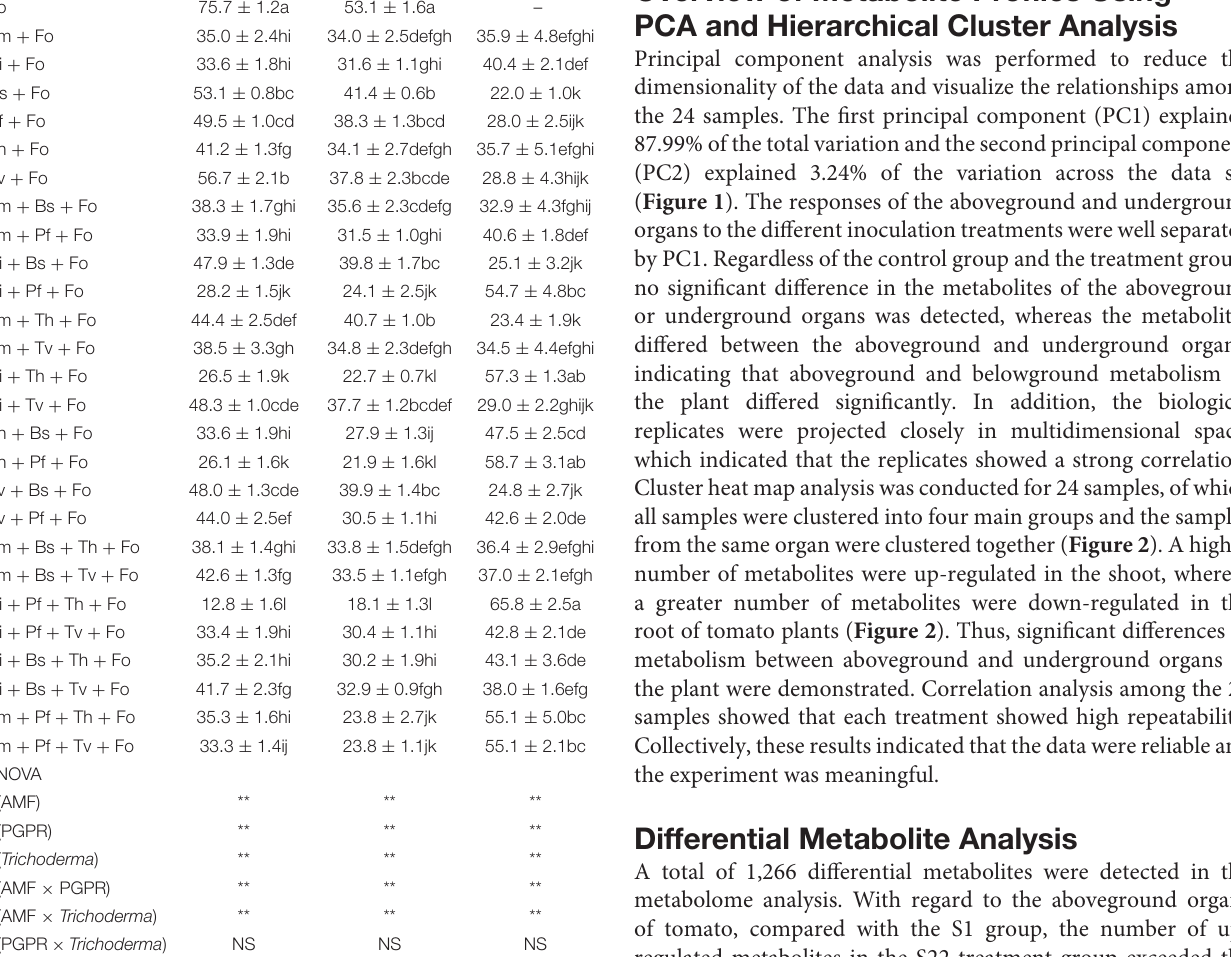
TABLE 3 | Effects of AMF, PGPR, and Trichoderma spp. on TFCRR disease. Inoculation Disease incidence